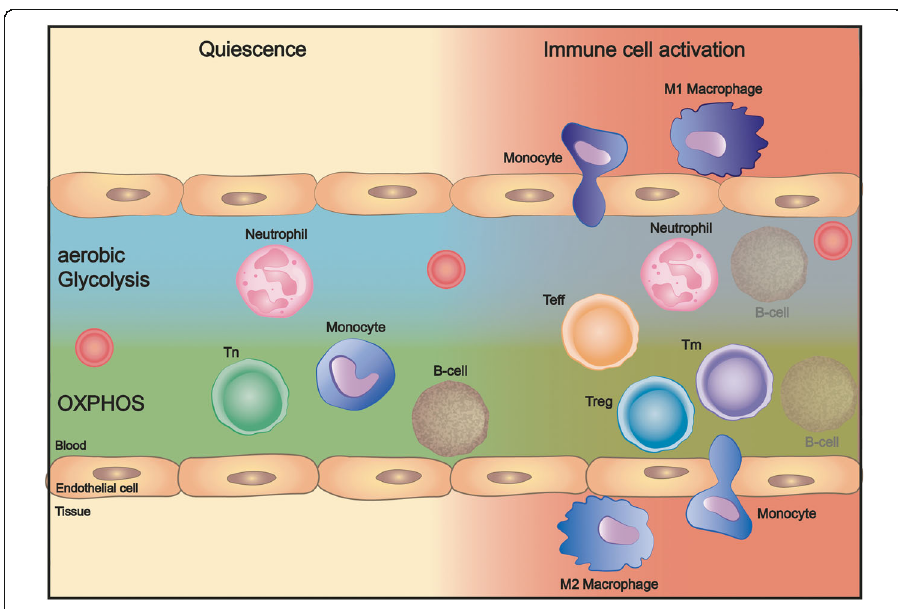
Fig. 2 Metabolic pathways of distinct immune cell subsets in quiescence and upon activation. Under quiescent conditions, neutrophils rely on aerobic glycolysis, whereas T n cells, monocytes, and B cells preferentially rely on OXPHOS for ATP production. Immune cell activation reshapes the metabolic demands of immune cells performing their various effector functions, differentiation to T eff , T reg , or T m cells, and migration across the endothelium into the tissue, where substrate and oxygen availability can be